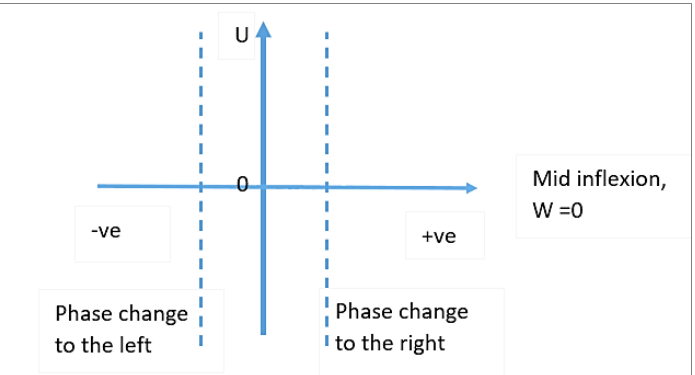
Figure 8. The limits of phase transition boundaries from linearity to non-linearity at the mid-inflexion zero